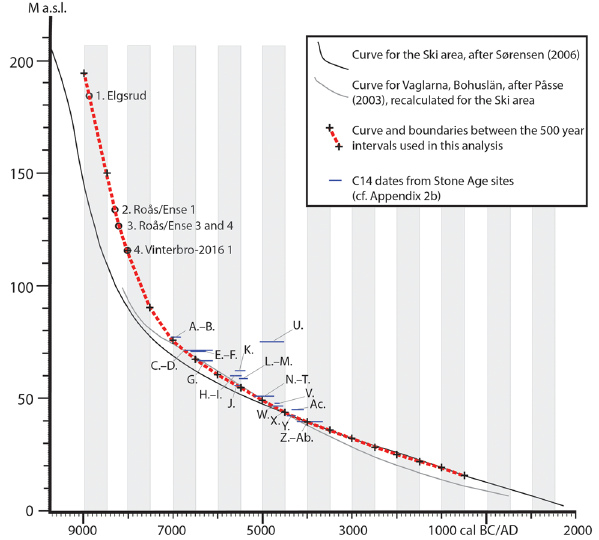
Figure 5: The analysis in this article is based on a compilation of geological data ( Påsse, 2003; Sørensen, 2006 ) and the archaeological record from the region. Illustration: Per Persson and Axel Mjærum,